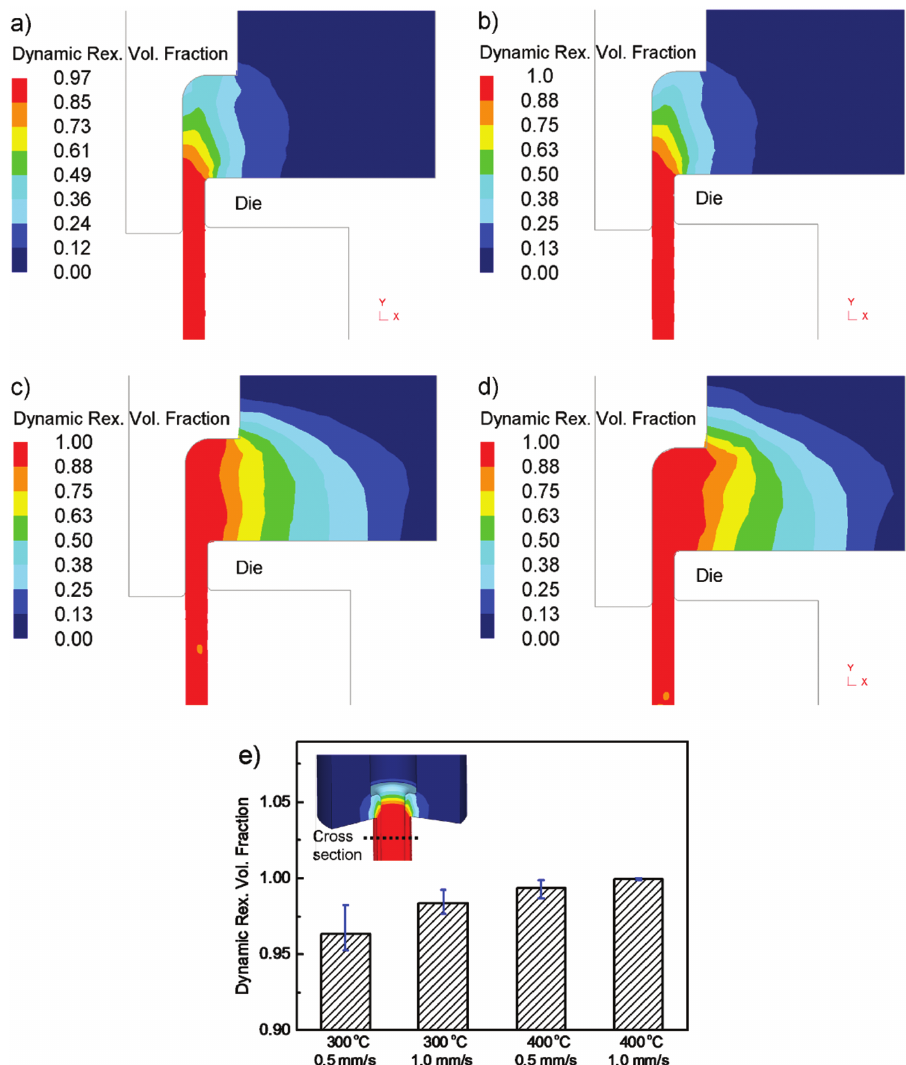
Figure 9: Distribution of dynamic recrystallization fraction on the cross-section, under different extrusion conditions: (a) 300 ℃ , 0.5mm/s; (b) 300 ℃ , 1mm/s; (c) 400 ℃ , 0.5mm/s; (d) 400 ℃ , 1mm/s; and (e) volume